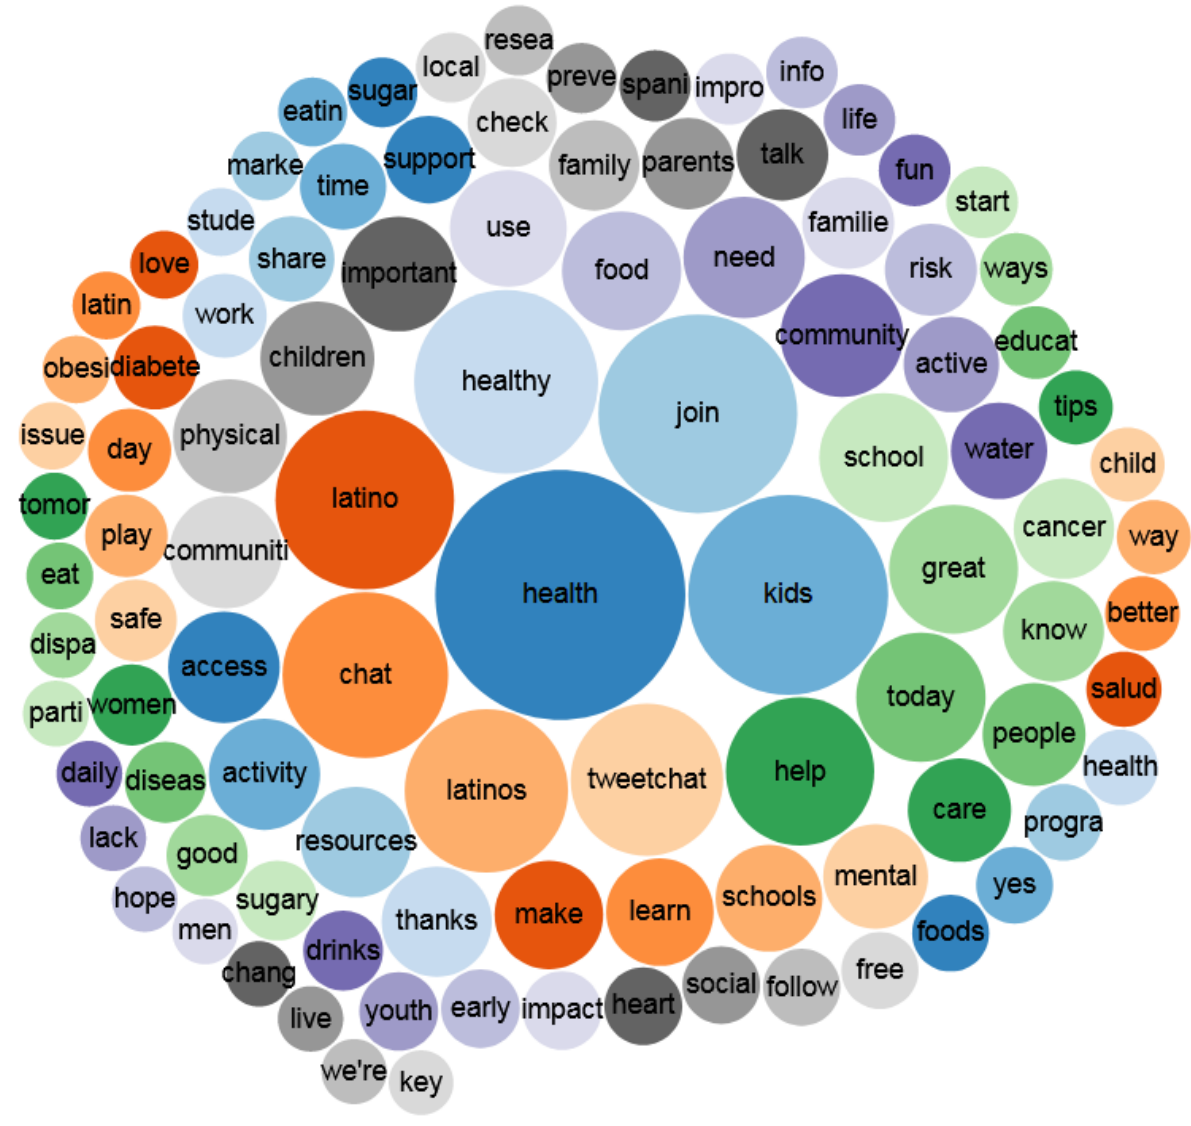
Figure 3. A bubble chart visualizing the 100 most frequently used words in tweets with the hashtag #SaludTues between November 1, 2014 and August 31,